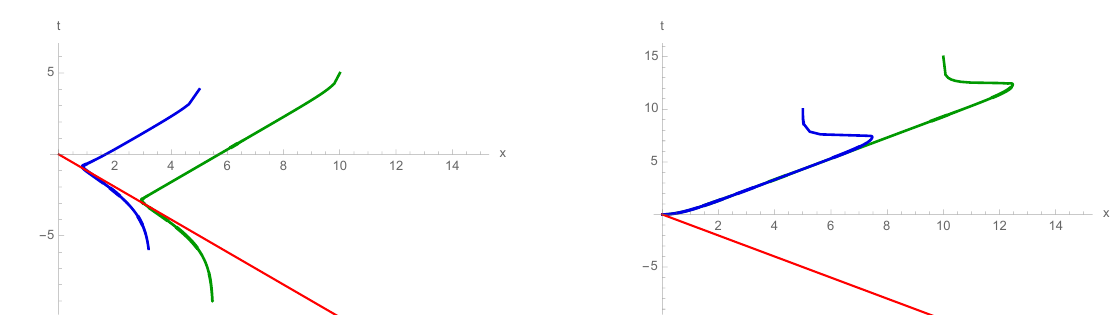
Figure 6 . Geodesics for ( b; T ) = (5 ; 4) ; (10 ; 5) (left) and (5 ; 10) ; (10 ; 15) (Right). In red we show the end of the world brane. Here we consider a projection in the z coordinate, which we expect to become the membrane in the scaling